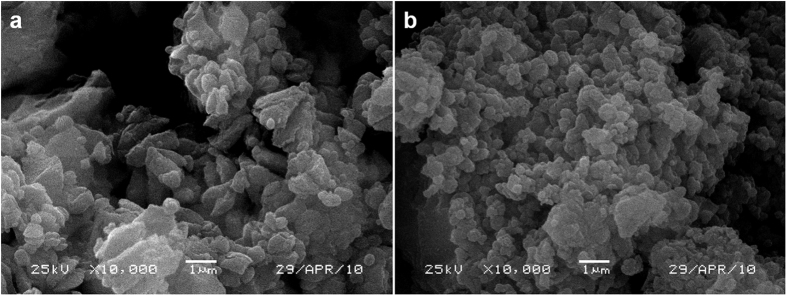
SEM images of: (a) as-milled LiAlH4, (b) LiAlH4-1 wt% NiCo@G.